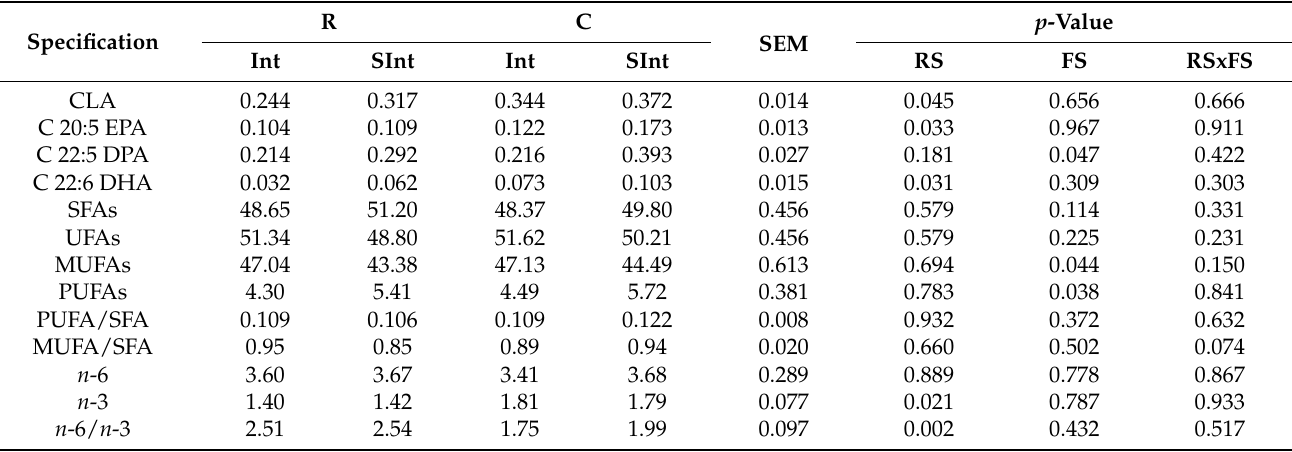
Table 4. The influence of rearing system and intensity of fattening on the fatty acids proportions (% of total) in the longissimus lumborum intramuscular fat.